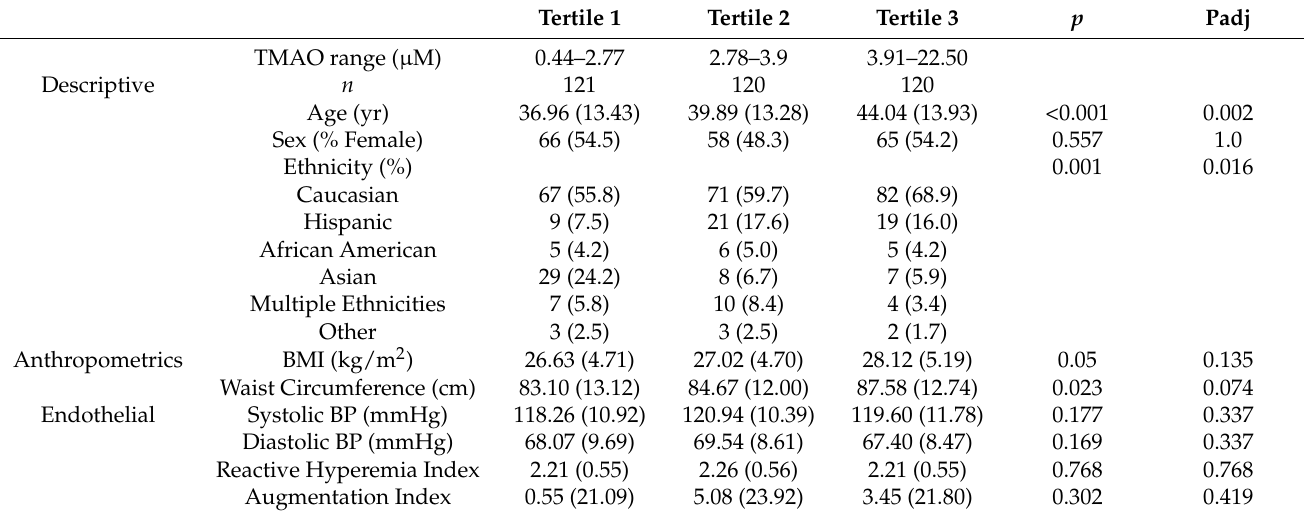
Table 1. Participant characteristics by TMAO